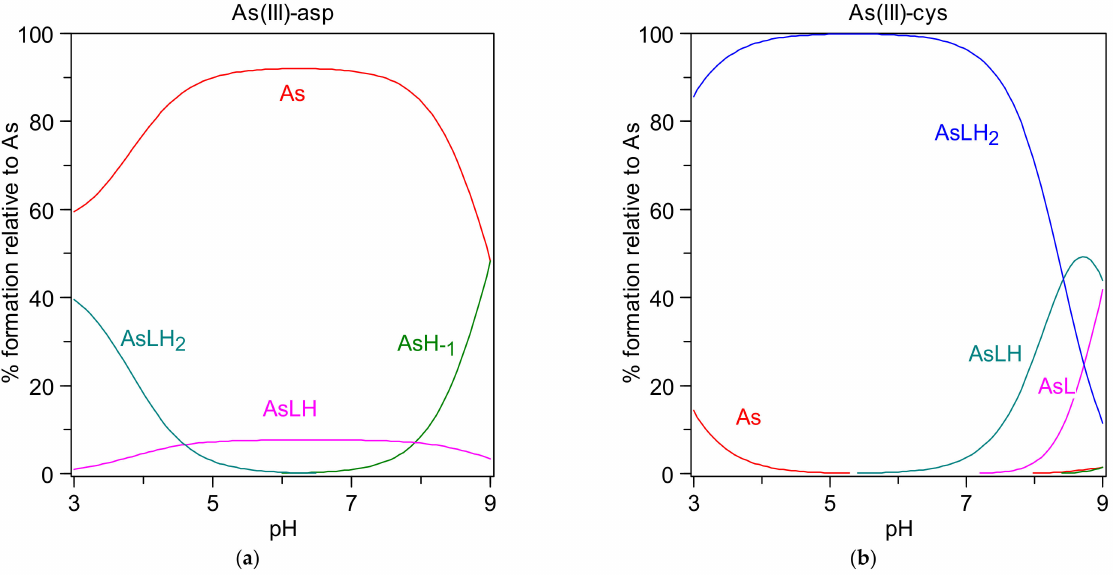
Figure 2. Distribution diagrams of ( a ) As(III)- asp and ( b ) As(III)- cys systems. Conditions: C As = 3 mmol/L, C L = 6 mmol/L, I = 0.15 mol/L (NaCl), T = 298.15